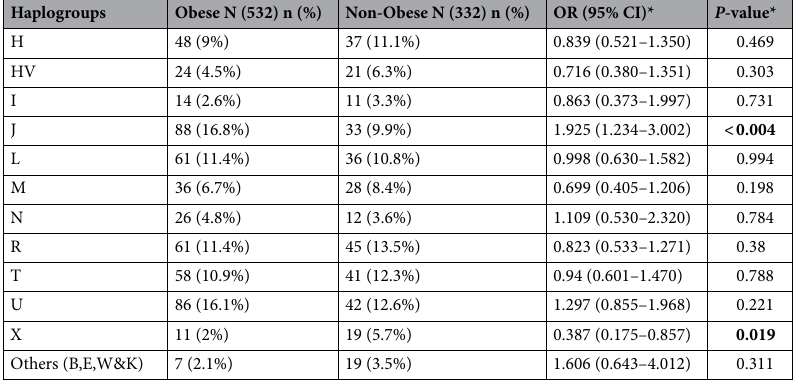
Table 3. Mitochondrial haplogroups associated with obesity in Qatari population. *Values after adjustment for age and sex. Abbreviations: N, number of individuals; OR, odds ratio; CI, confidence intervals of logistic regression test.